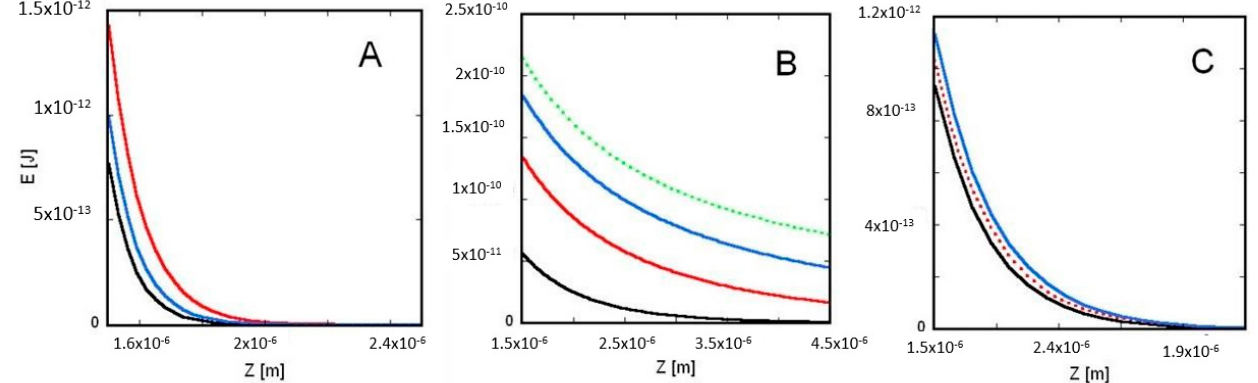
Figure 2. Interaction energy of two charged spheres surrounded by electrolyte (dependence from electrolyte’s ion concentration and temperature): the smaller sphere with radius R 1 = 5 × 10 − 7 m is located to the left of the larger sphere with radius R 2 = 10 − 6 m (Figure 1). The interaction energy between the two spheres, E , is calculated by Equation (10) and plotted against the distance between the centers of the two spheres, ( ≥ R 1 + R 2 = 1.5 × 10 − 6 m). ( A ) The ion concentration, C , of the electrolyte (and the respective Debye length from Equation (A2)) is: red curve: 0.007 mol/m 3 ( λ D = 1.15 × 10 − 7 m); blue curve: 0.01 mol/m 3 ( λ D = 9.62 × 10 − 8 m); and black curve: 0.013 mol/m 3 ( λ D = 8.44 × 10 − 8 m), and the temperature in the case of each curve is T = 300 K. ( B ) The ion concentration of the electrolyte is: green dotted curve: 0 mol/m 3 ( λ D = ∞ m); blue curve: 0.000001 mol/m 3 ( λ D = 9.62 × 10 − 6 m); red curve: 0.00001 mol/m 3 ( λ D = 3.04 × 10 − 6 m); and black curve: 0.0001 mol/m 3 ( λ D = 9.62 × 10 − 7 m), and the temperature in the case of each curve is T = 300 K. ( C ) The system’s temperature (and the respective Debye length) is: blue curve: 340 K ( λ D = 1.02 × 10 − 7 m); red dotted curve: 310 K ( λ D = 9.78 × 10 − 8 m); and black curve: 280 K ( λ D = 9.30 × 10 − 8 m), and the electrolyte’s ion concentration in the case of each curve is 0.01 mol/m 3 . In the case of our calculations, the surface-charge density of each charged sphere is ρ s = − 0.266 × C /m 2 .